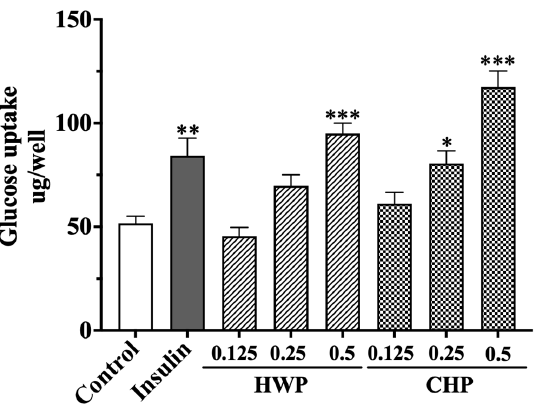
Figure 5. Effects of different concentrations of TPs (0.125, 0.25, and 0.5 mg/mL) extracted by different methods on glucose uptake in L6 cells. Each value represents the mean ± SEM of three independent experiments. * p < 0.05, ** p < 0.01, and *** p < 0.001.